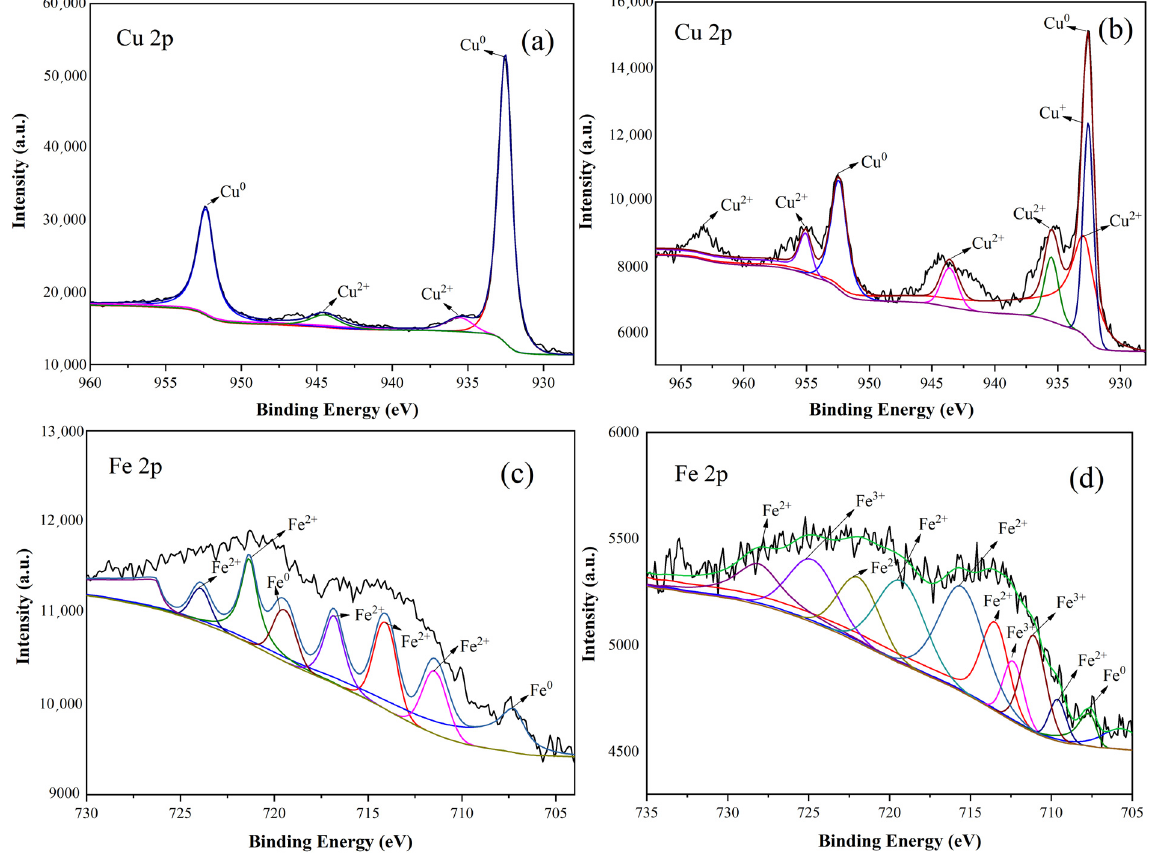
Figure 4. XPS of Cu-SSE: ( a , b ) Cu 2p before and after the EF reaction; ( c , d ) Fe 2p before and after the EF reaction .